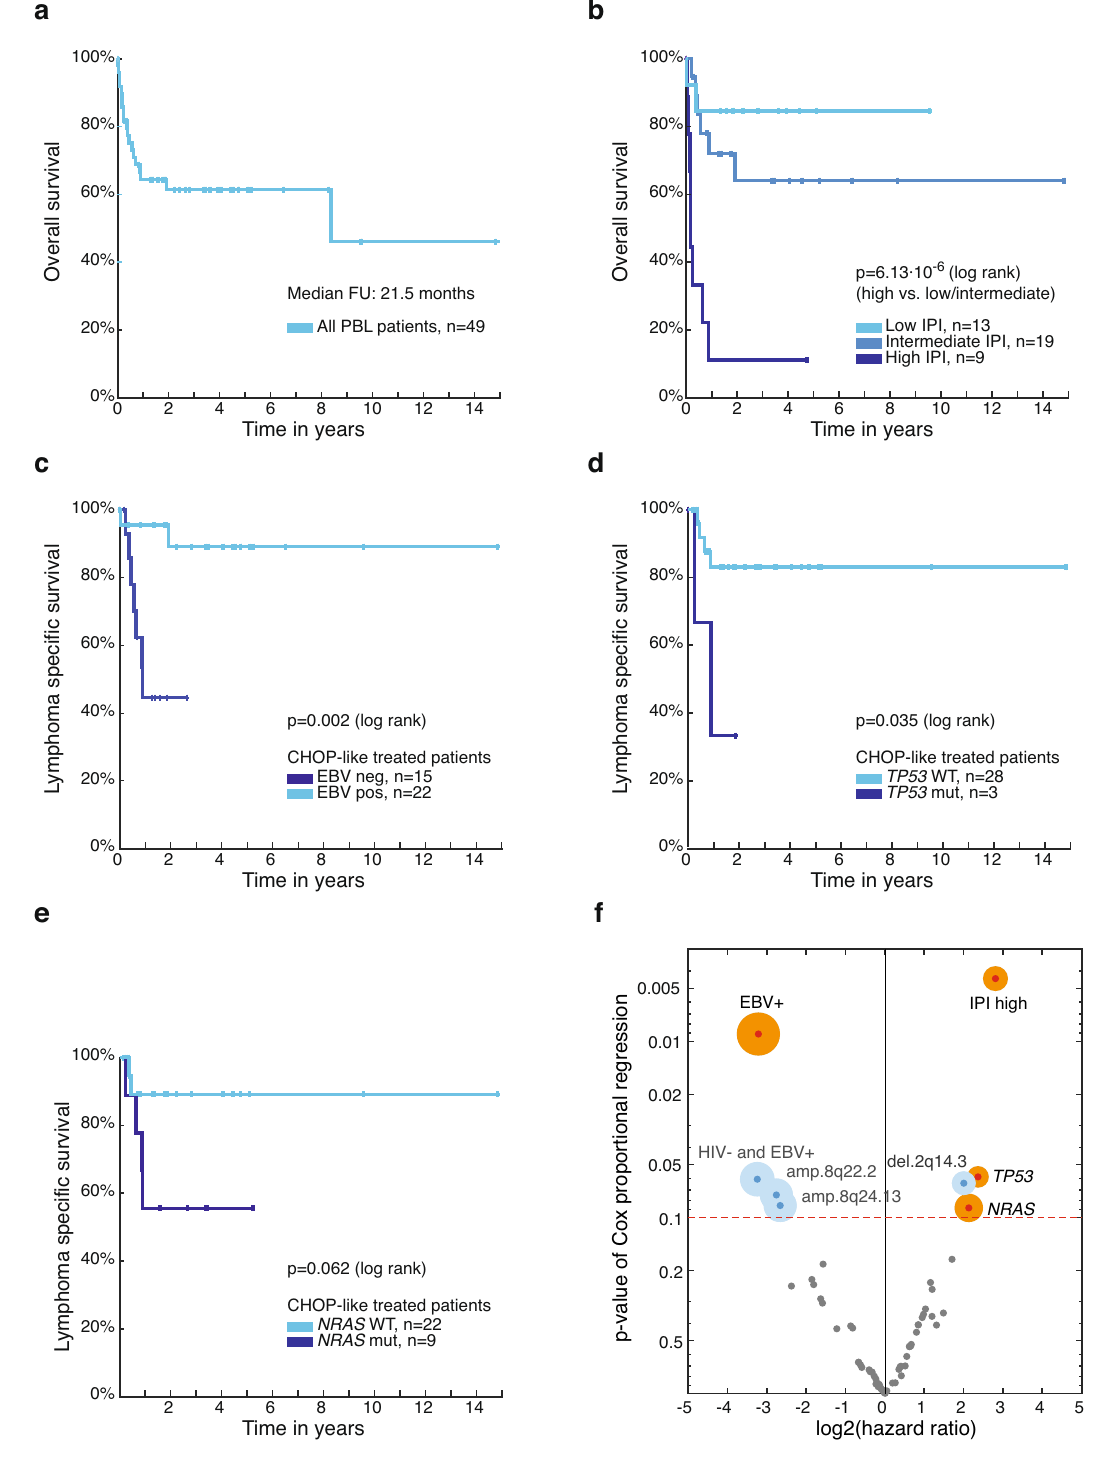
Fig. 3 Survival analysis of PBL patients. Kaplan – Meier (KM) estimates showing a overall survival (OS) for all PBL patients with available follow-up (FU) ( n = 49) and b OS according to IPI group (IPI low: 0 – 1, IPI intermediate: 2 – 3, IPI high: 4 – 5). Lymphoma-speci fi c survival (LSS) shown for PBL patients treated with CHOP-like chemotherapy depending on c EBV infection status of lymphoma (neg negative, pos positive), on d mutational status of TP53, and e NRAS (wt wildtype, mut mutated). Corresponding p values of two-sided log rank tests are shown, for multiple hypothesis testing over preselected conditions see Supplementary Data 9. f Hazard ratios by Cox regression and corresponding p Cox values describing the impact of signi fi cant mutations, SCNAs (with q M2CV/G2.0 < 0.1) or clinical metadata on LSS for PBL patients treated with CHOP-like chemotherapy. The size of the circle for parameters with p value <0.1 is proportional to the number of affected patients. Earlier fi ndings con fi rmed by this unbiased exploratory analysis are highlighted in orange. No signi fi cant hypotheses with FDR q < 0.1 were